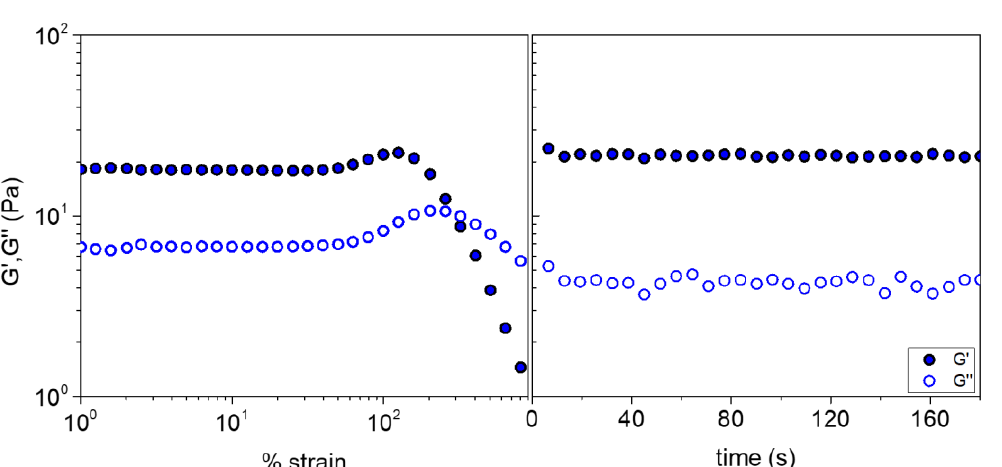
Figure 8. G’ (closed symbols), G” (open symbols) as a function of strain at 1 Hz (strain sweep, left ), followed consecutively by time sweep ( right ), applying low strain of 0.1% within the linear viscoelastic regime at 37 °C for the ALG/HGC formulation.